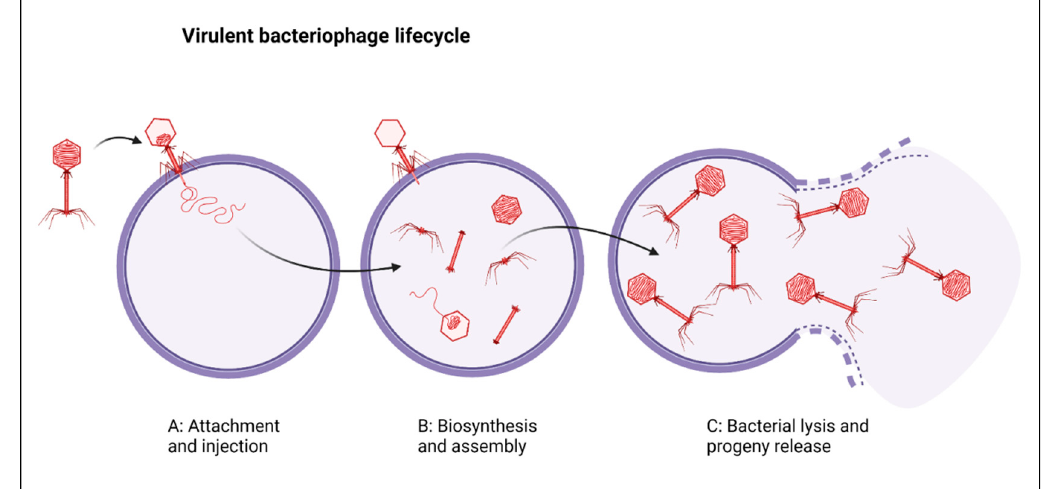
Figure 1. ( A ) Phage (depicted in red) attachment and injection of its genome into a host bacterium (circular purple cell). ( B ) Bacterial cellular machinery is used to synthesise and assemble new phage progeny. ( C ) Progeny are released due to bacterial cell lysis. Created with BioRender.com (31 May 2021).